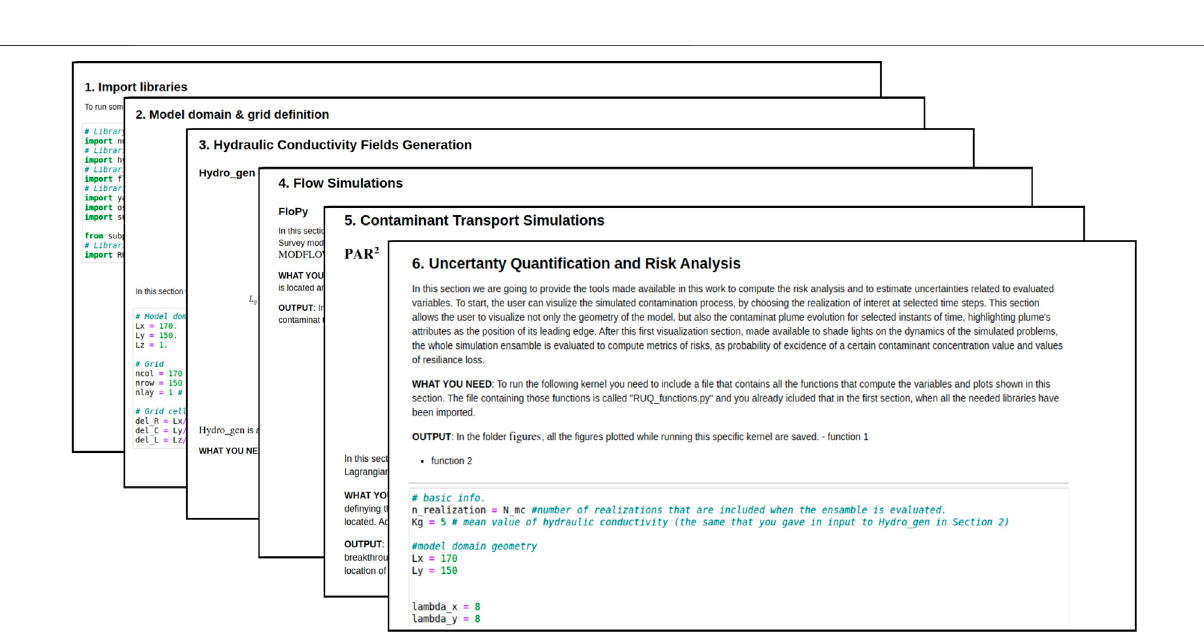
Frontiers in Earth Science |